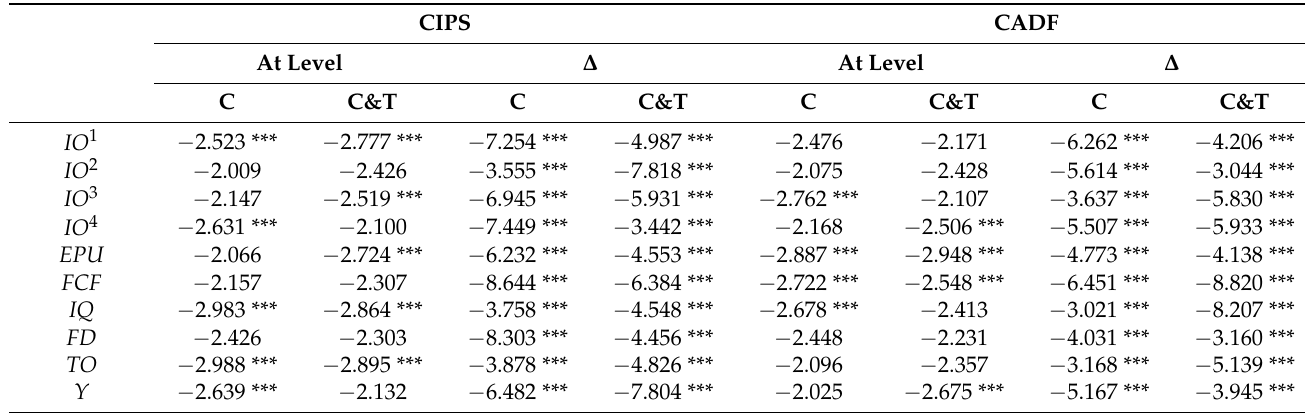
Table 6. CIPS and CADF unit root tests.